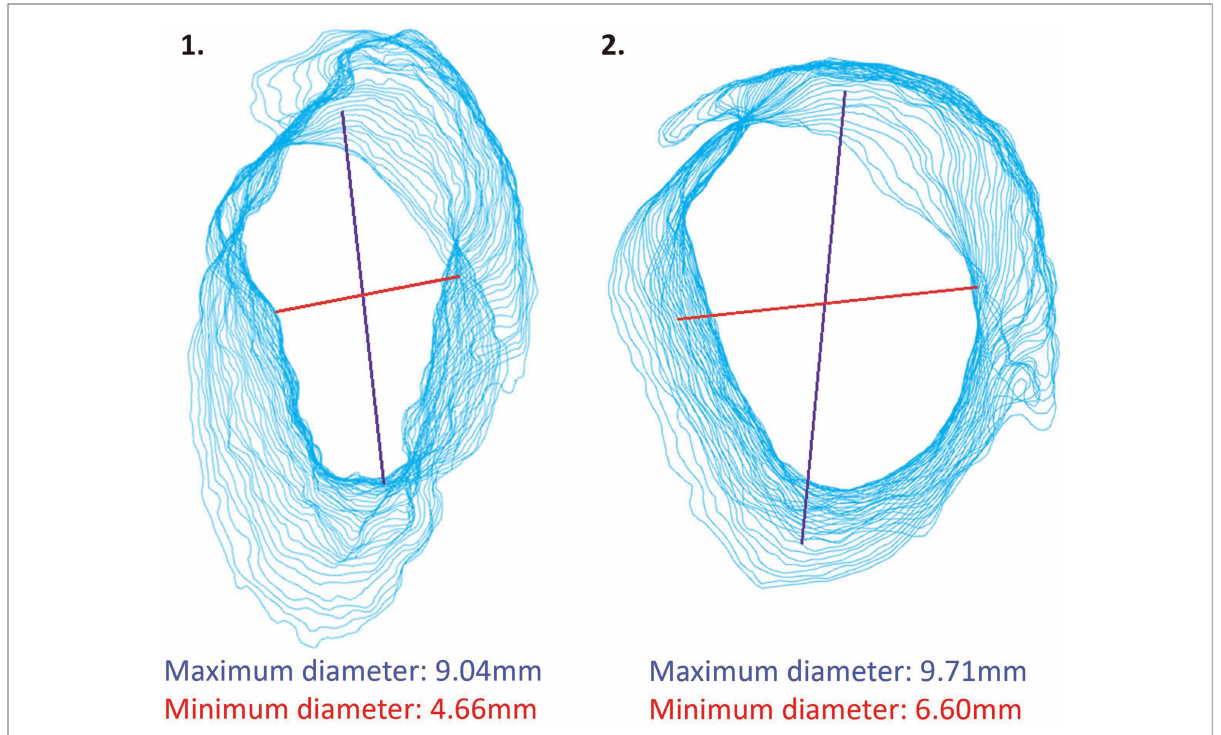
FIGURE 6 Two different ear canal characteristics. The blue line is the maximum diameter and the red line is the minimum